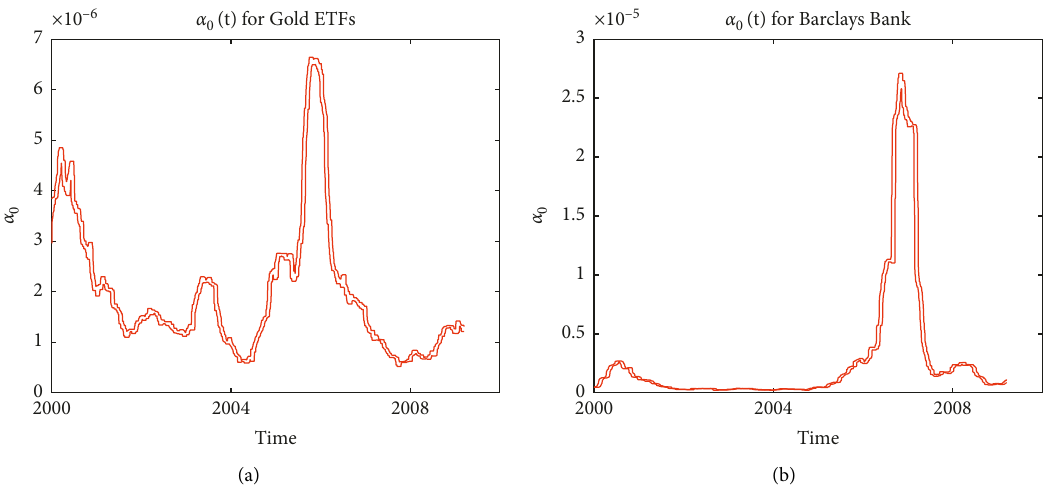
Figure 8: Γ as a function of the running parameter α . Here, we show how we calculate the value of α 6 0 � Γ orange line is the value of Γ for the empirical time window, Γ , whilst the blue line shows Γ 6 6 6 , emp ( η , α , σ 2 , Γ ) (equation (24)) and β � β ( η , α , σ 2 , Γ ) (equation (25)), for the GARCH-double-normal model. The in- α 1 0 4 , emp 0 4 , emp 4 1 1 4 emp emp tercept of the two lines shows the value of α which allows us to model data for a certain median time and a certain time window within the 0 GARCH-double-normal (1,1) model.